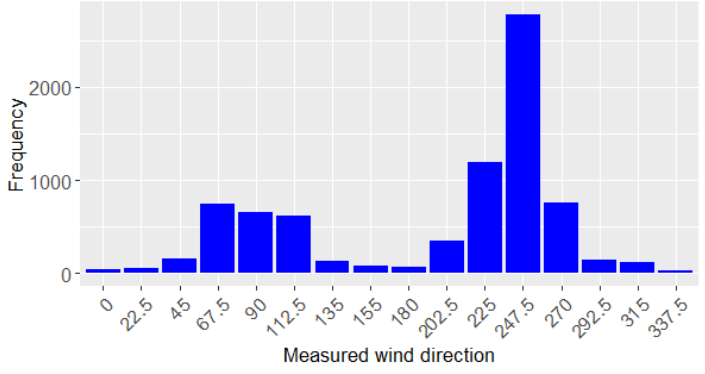
Figure 8. Frequency of each measured wind direction during the studied 1-year